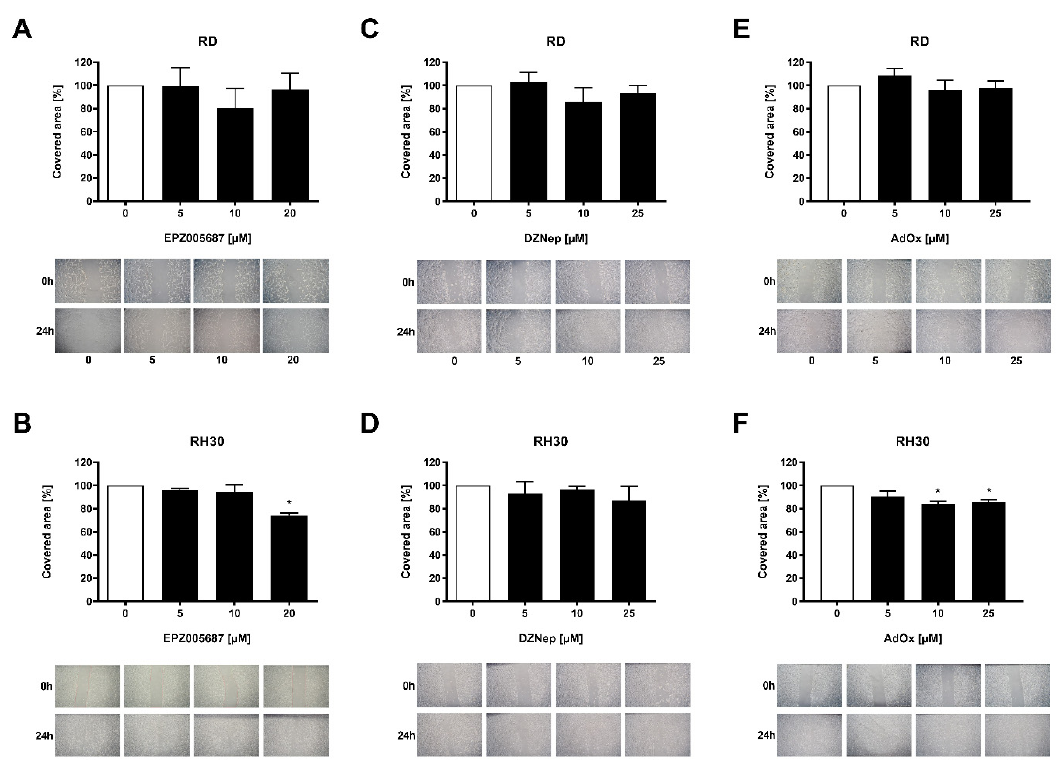
Figure 3. Migration behavior of RMS cells in response to EZH2 inhibitors. A wound healing assay was performed to assess migration. Relative numbers of migrated RD (upper row) and RH30 (lower row) cells following a 72 h incubation in the absence (white bars) and presence (black bars) of increasing concentrations of EPZ005687 ( A , B ), DZNep ( C , D ), and AdOx ( E , F ). The untreated control was set as 100%. Error bars represent mean +/ − SEM ( n = 4). p * ≤ 0.05 indicates statistical significance. A representative image of the wound healing assay is shown for each concentration of the